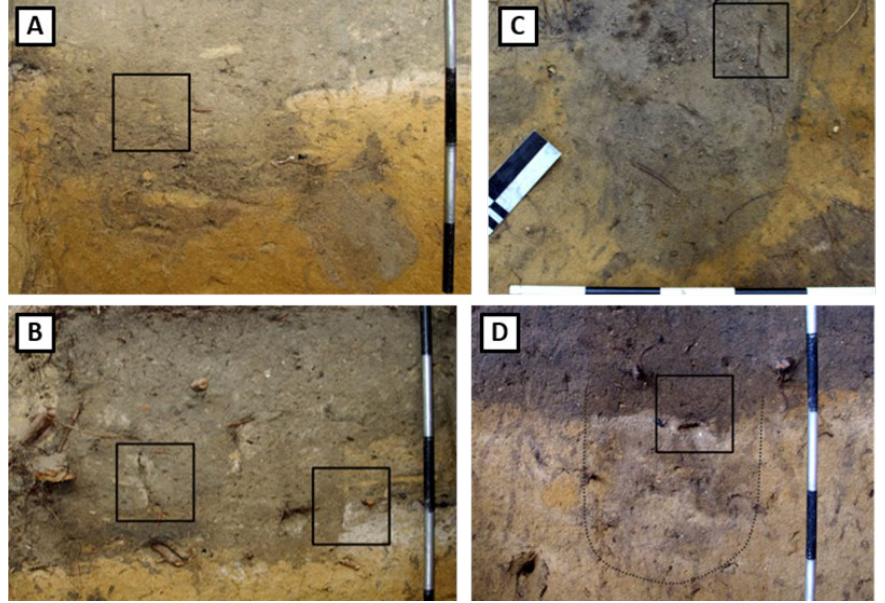
Figure 5. Archaeological pit features sampled at the Fort Odanak site (CaFe-7). ( A ) Pit feature 12A57 ( ⁓ 50 cm/surface, profile view) ( B ) Pit feature 12A64 ( ⁓ 47 cm/surface, profile view) ( C ) Pit feature 12A72 ( ⁓ 55 cm/surface; plan view) ( D ) Pit feature 12F50C ( ⁓ 35 cm/surface, profile view); Squares mark the placements of kubiëna boxes.